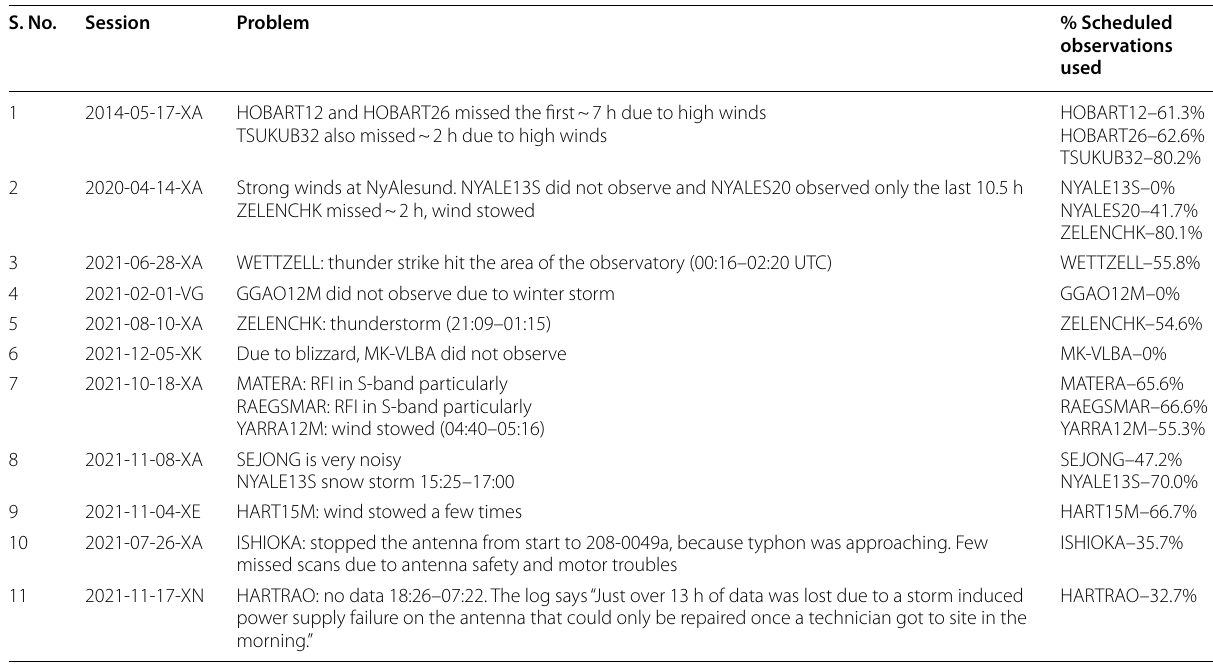
Table 6 Detailed snippets of few examples from the IVS analysis